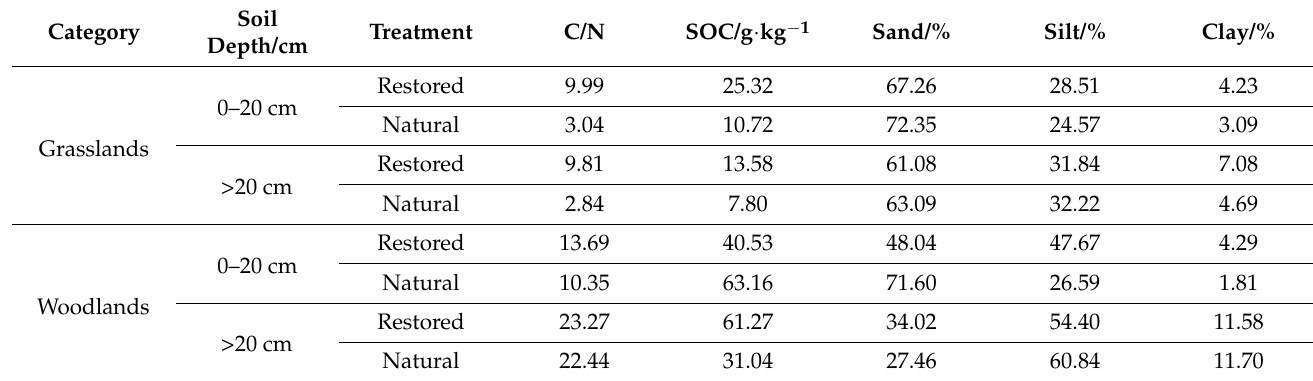
Table 1. Comparison between restored and natural